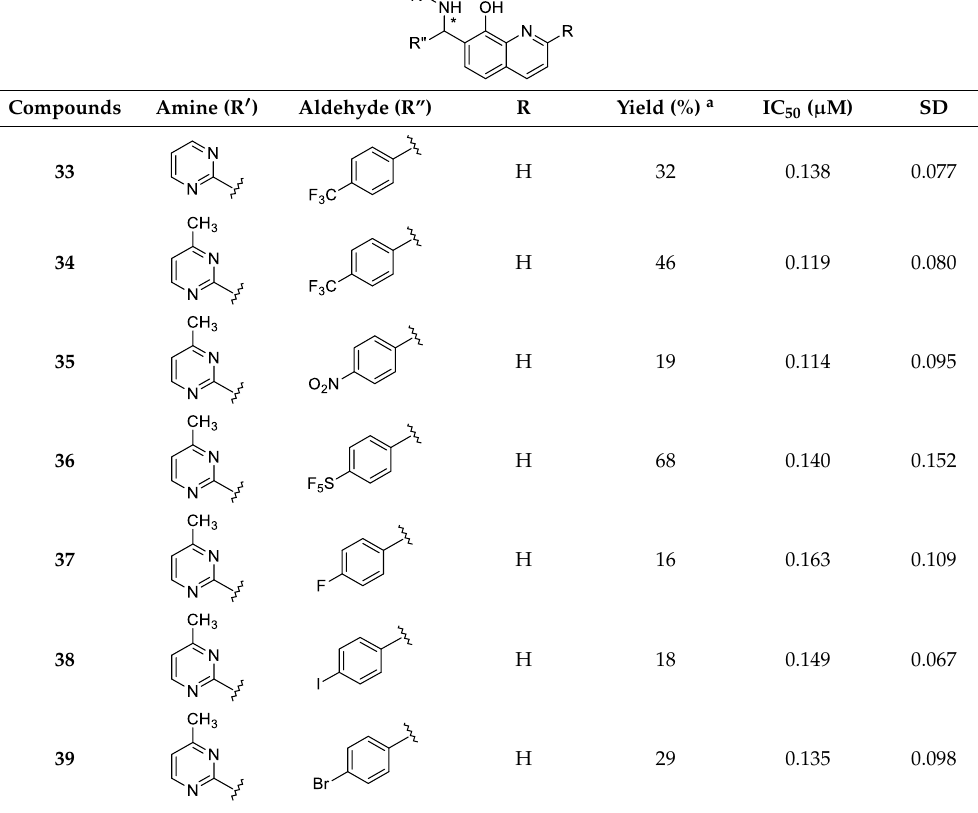
Table 3. Functionalization with several pyrimidines (Subclass 3).